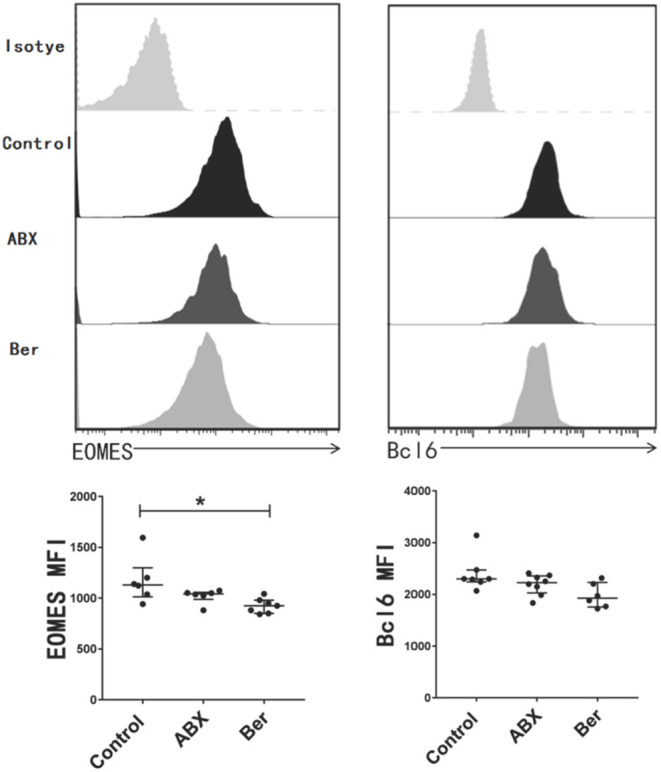
Berberine inhibits the expression of EOMES in CD8+ T cells. dLN cells were harvested 14 days after allotransplantation with various treatments. The expression of EOMES and Bcl-6 in CD8+ T cells was detected via a flow cytometer and quantified as mean fluorescence intensity (MFI). Histogram is shown after gating on CD8+ population. Plots of individual values are presented as median ± interquartile range (*P < 0.05, n = 6–8 mice/group).